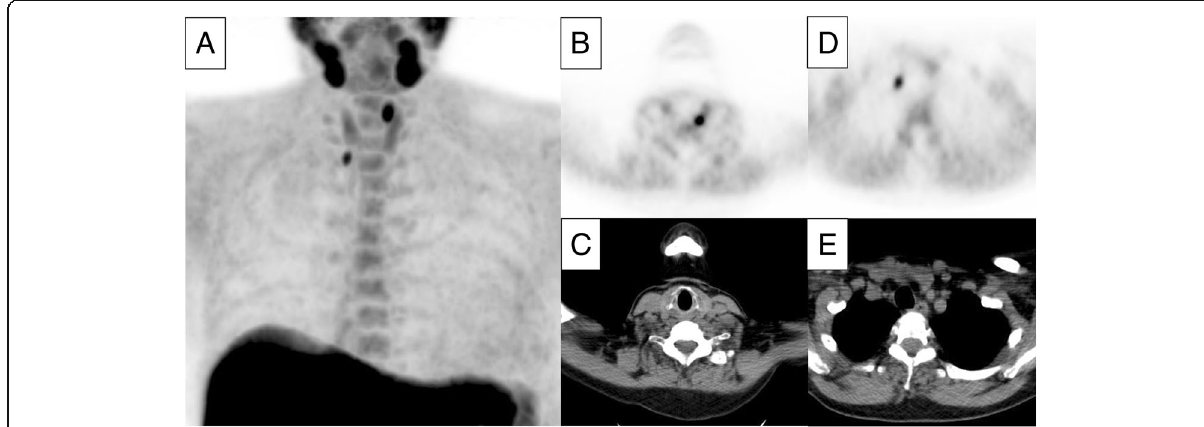
Fig. 1 Example of a positive 18 F-fluorocholine PET/CT representing a double parathyroid adenoma. Serum calcium level in this patient was 2.61 mmol/L with a parathyroid hormone level of 27.7 pmol/L. The maximum intensity projection image ( a ) shows two foci of intense choline uptake in the neck and physiological uptake in the salivary glands, thyroid gland, liver, spleen, and bone marrow. Axial views of PET and CT show foci suspicious for parathyroid adenomas located dorsocranial to the left thyroid lobe ( b , c , dimensions 7 × 5 mm and SUV max of 8.7) and inferior to the right thyroid lobe ( d , e , dimensions 6 × 4 mm and SUV max of 5.6)